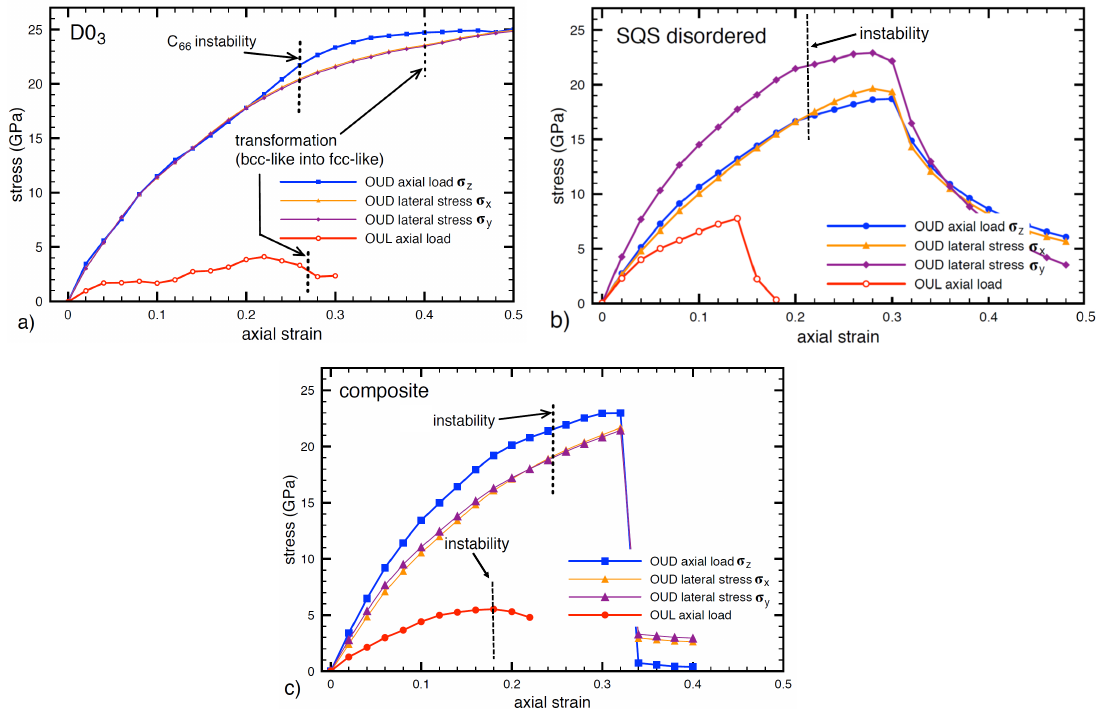
Figure 2. The stress-strain dependencies obtained from ab initio simulations for the uniaxial deformation (OUD) and uniaxial loading (OUL) deformation models for perfect Fe 3 Al with the D0 3 structure ( a ), a disordered Fe-Al phase ( b ) and their nanocomposite ( c ). The blue, magenta and orange curves represent axial and two transverse stresses for the OUD model while the red one belongs to the axial load of the OUL model. Elastic instabilities are marked by black dashed